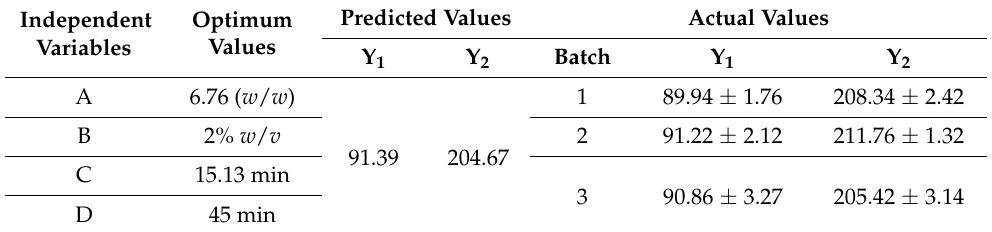
Table 5. Optimum conditions attained by applying restrictions on the response parameters.